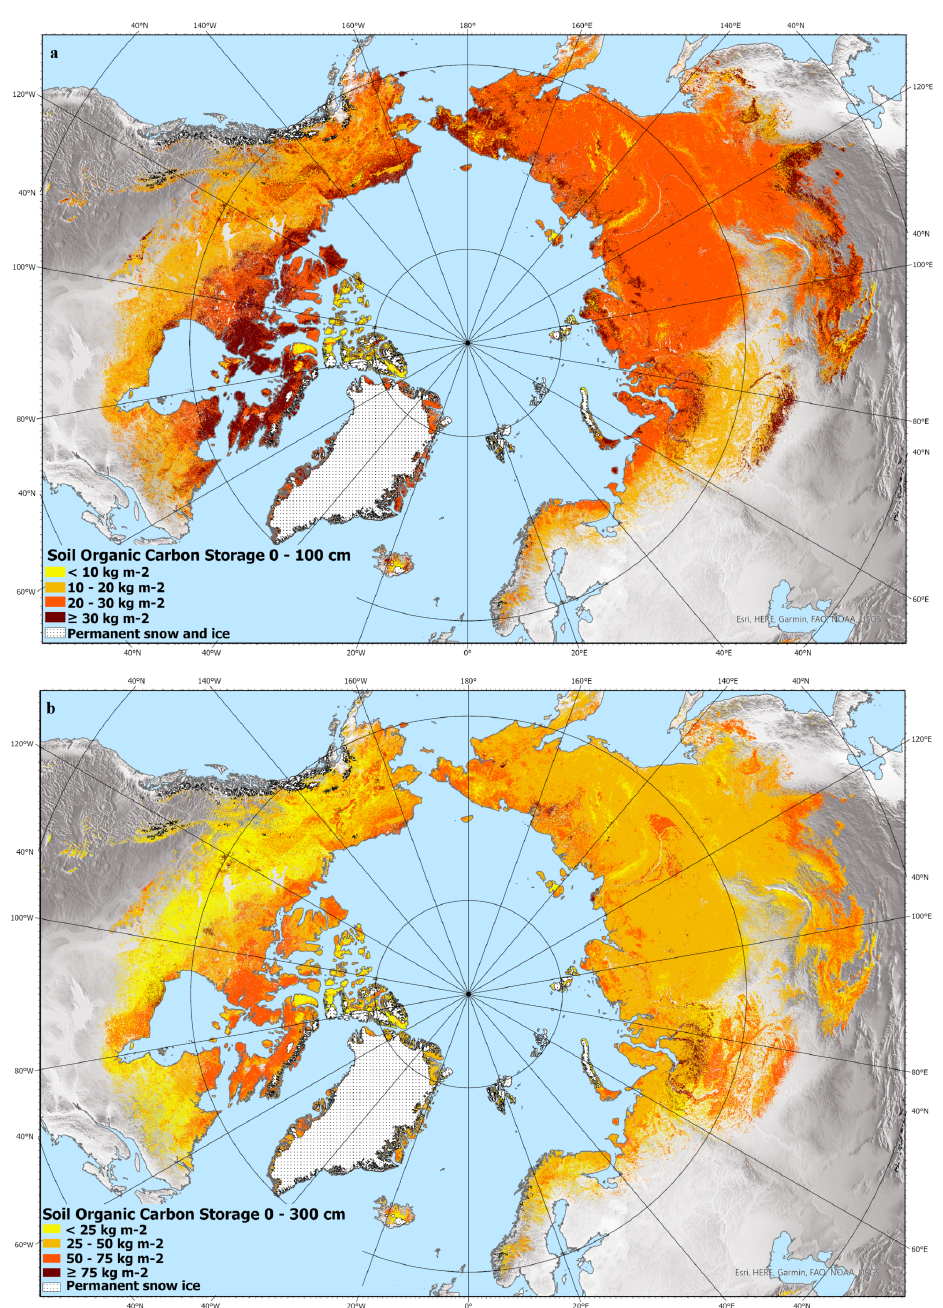
Figure 3. Estimated total SOC storage (kgCm − 2 ) to a depth of 0–100cm (a) and 0–300cm (b) in northern circumpolar permafrost region. North Pole Lambert azimuthal equal area projection (datum: WGS 84). Base map: made with Natural